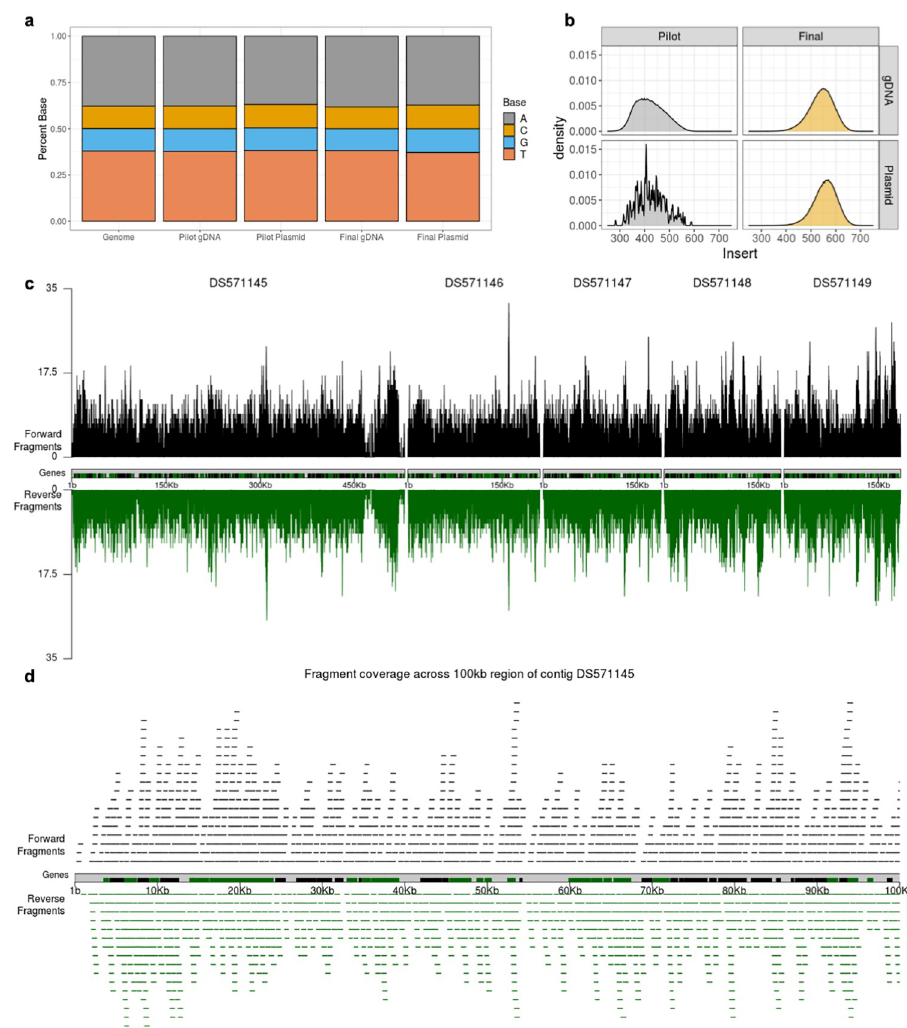
Fig 3. The final RNAi library has genome-wide coverage. a, Nucleotide frequency analysis of the HM1:IMSS reference genome, the pilot and final gDNA fragments, and the pilot and final plasmid libraries. Stacked bar plots show the percentage of each base. The nucleotide composition of the gDNA fragments and the final plasmid library is the same as the genome. b, Histograms showing the distribution of fragments sizes for the unique fragments in the pilot and final gDNA fragments, and the pilot and final plasmid libraries. Size in nucleotides is plotted on the X axis, and probability distribution density is plotted on the Y axis. c, Genome coverage plots of the final library, over the five largest contigs in the reference genome. The positions of unique fragments and the depth in fragments overlapping each genomic position are shown. The positions of genes are shown with black and green bars. Fragments that are in the same orientation as genes that are in the forward orientation in the reference genome are shown in black, and fragments that are in the same orientation as genes that are in the reverse orientation in the reference genome are shown in green. d, Visual representation of fragment coverage in the final library, over 100 kb of contig